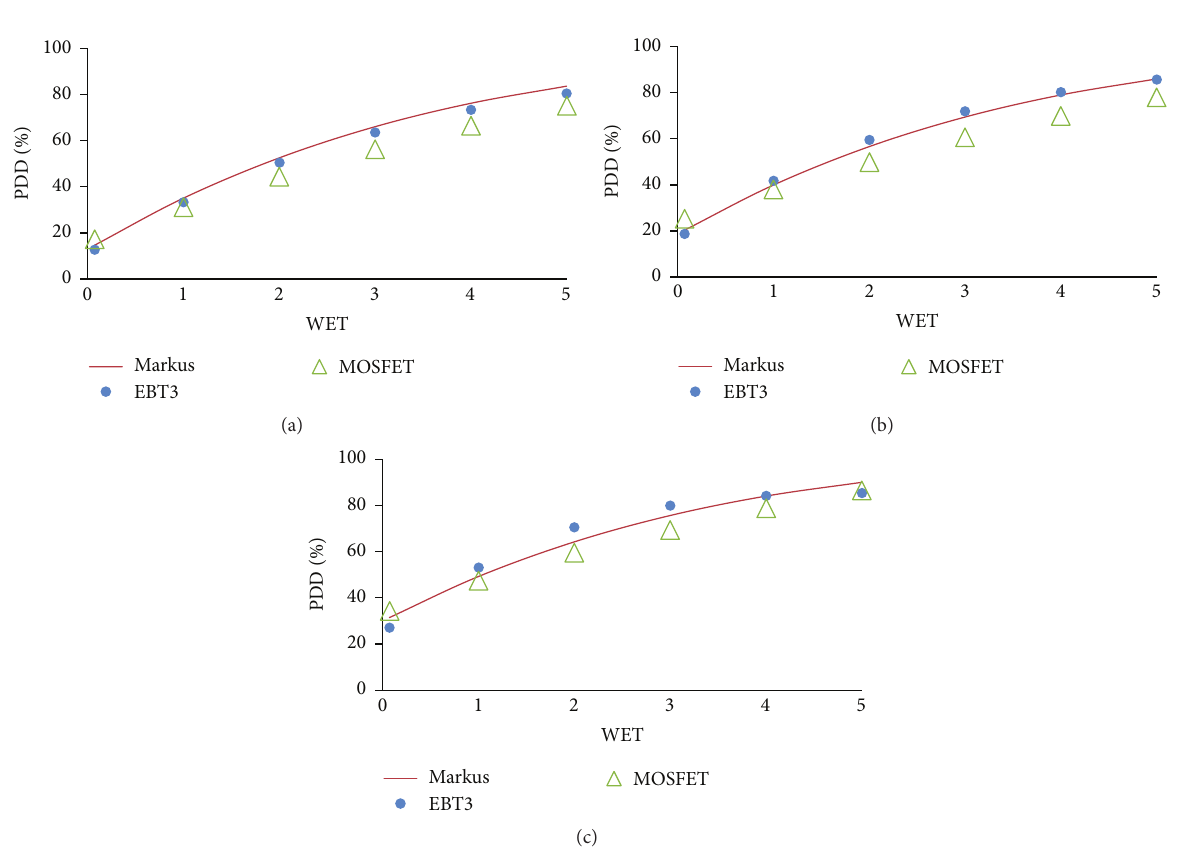
surface dose at 0.07 mm WET (14.6%, 20.3%, and 31.4% for 5 × 5, 10 × 10, and 20 × 20 cm 2 field sizes,